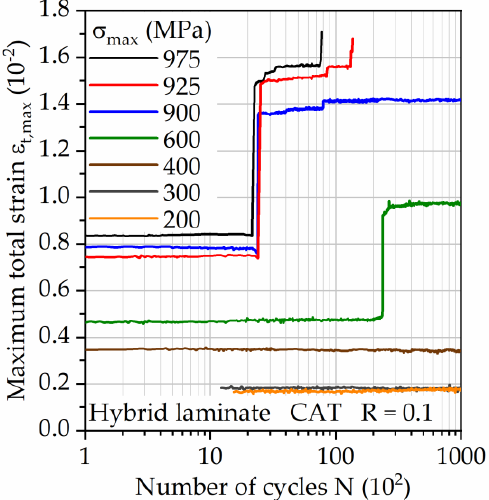
Figure 11. Maximum total strain measured via DIC during CAT on the surface of the hybrid laminate in 1/2-configuration of 1.4310 and carbon fiber reinforced PA 6.